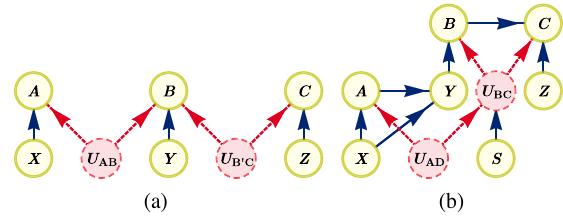
FIG. 3. DAG representation of two example causal scenarios with quantum latent nodes. (a) The tripartite-line causal scenario, where two causally independent parties A and C each share some quantum entanglement with a central party B , later denoted for brevity. (b) Arbitrary quantum-latent causal structures contain directed edges beyond the traditional network connections of latent-to-terminal edges and root-to-terminal edges. A method for analyzing correlations in general structures with quantum latent nodes is given in Sec.